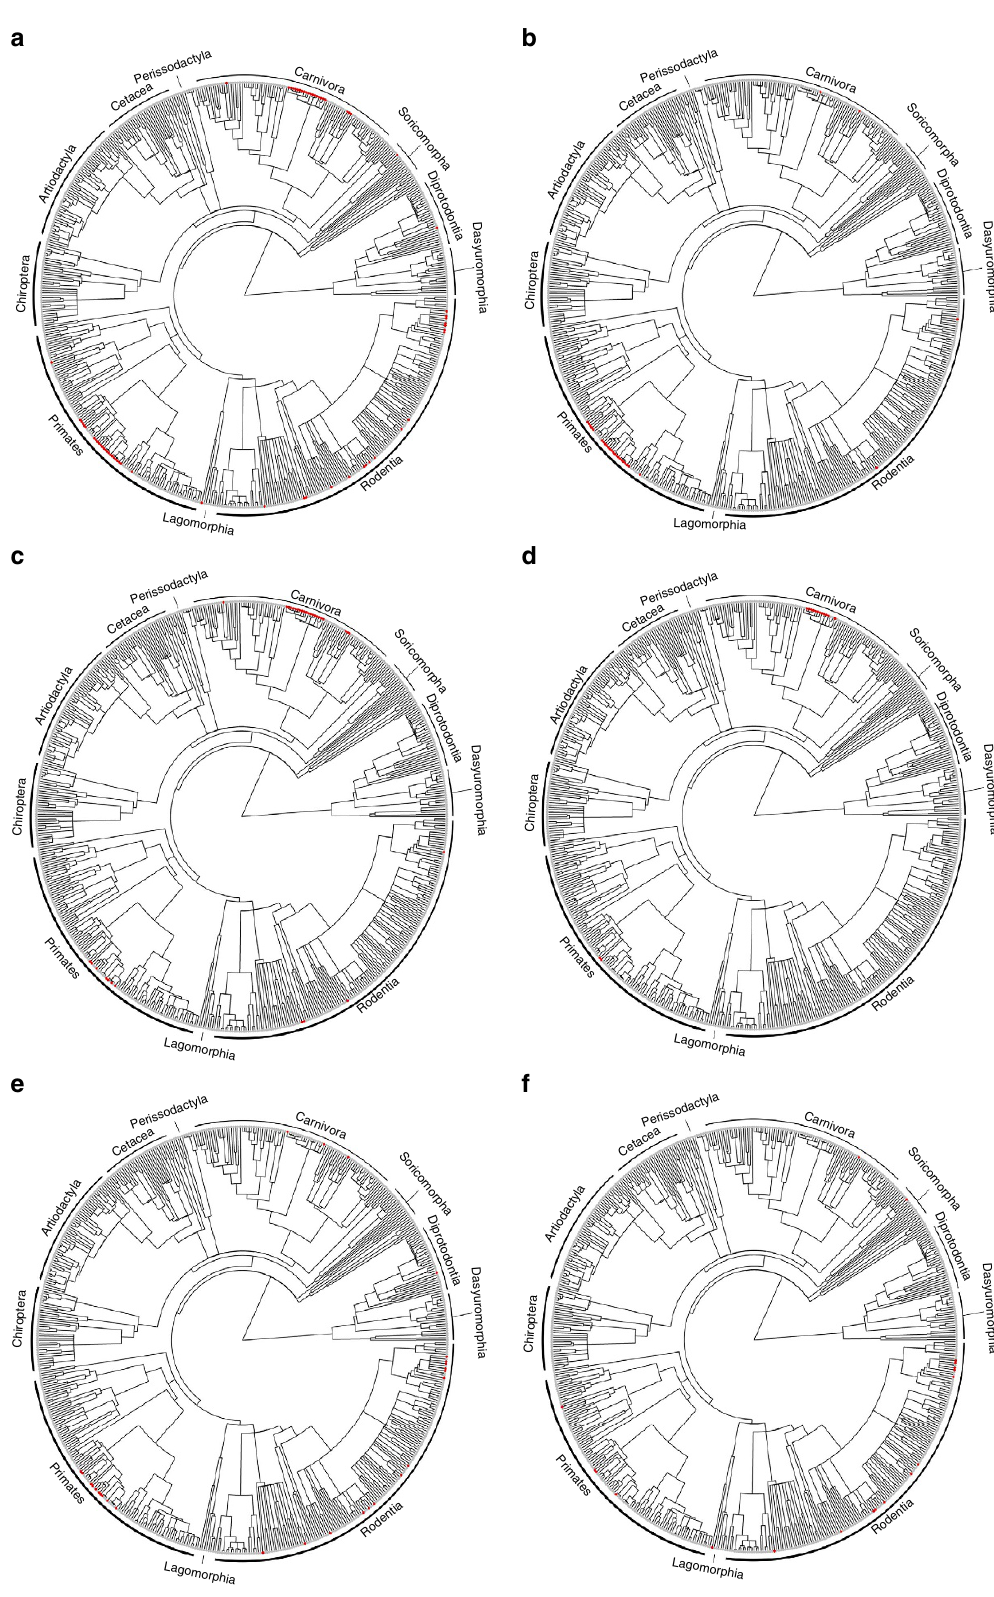
Figure 1 | Distribution of male care behaviours across the mammal phylogeny. ( a ) Male care (any behaviour, red dots) in mammals (65 species with and 464 species without any form of male care). Species with biparental care (red dots) are indicated as follows: species with ( b ) carrying ( n ¼ 27); ( c ) provisioning offspring ( n ¼ 31); ( d ) provisioning reproducing females ( n ¼ 15); ( e ) grooming ( n ¼ 28); and ( f ) huddling with the offspring ( n ¼ 19). In all panels, grey dots represent species without male